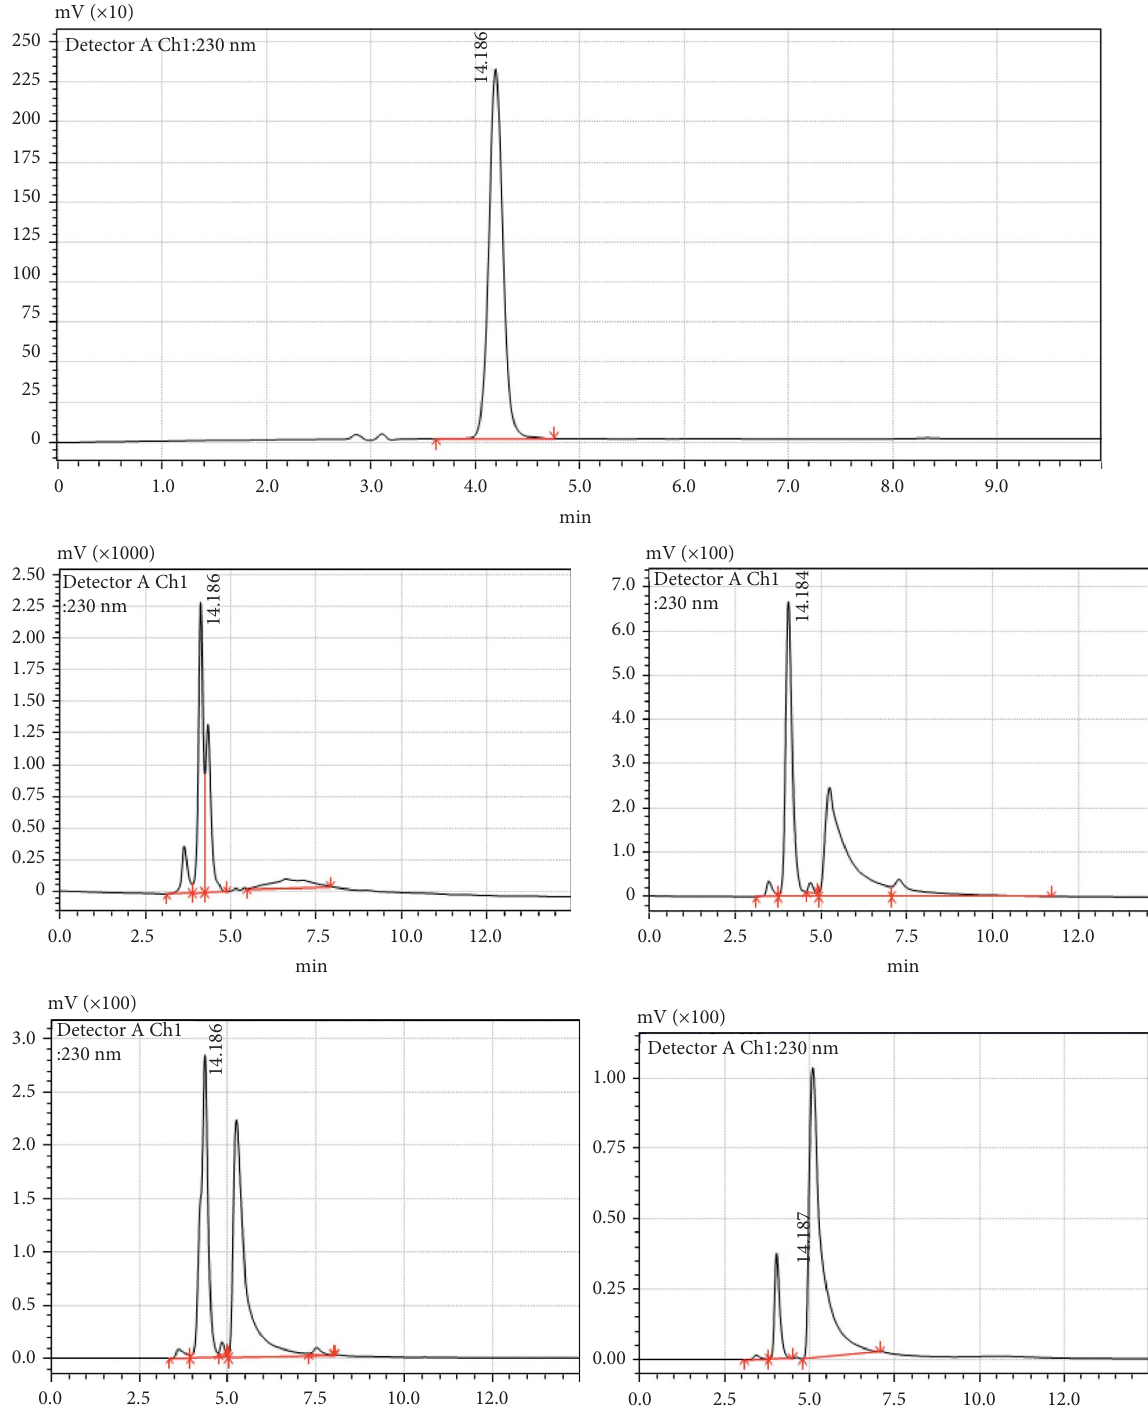
Figure 2: Chromatogram of Amox pure standard (100 μ g mL − 1 ) before heat treatment (a); the consequent chromatograms after boiling (b), showing the splitting of the standard peak due to heat treatment or cooking (5min); the main peak depletion of Amox, and the resulted quantifiable new peaks appeared after boiling the compound at 100 ° C (15–30min) (c, d), and the changes in the total peak area after heat treatment by boiling for 45 min